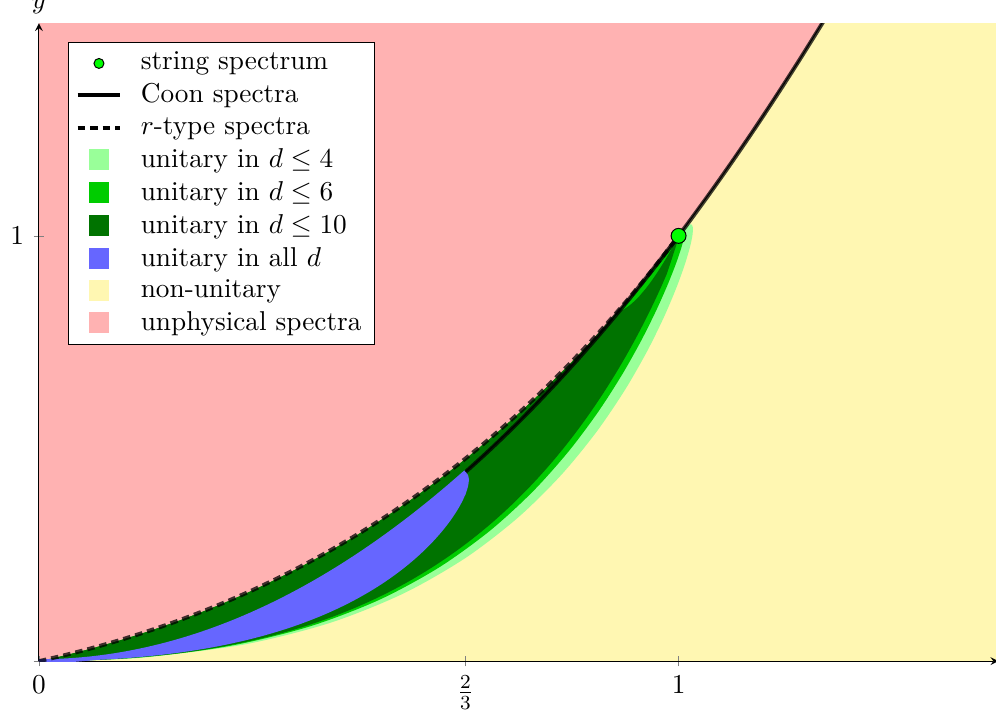
Figure 2 . The two-parameter space of solutions to the generalized Veneziano amplitude constraints with unitary regions in various dimensions. The blue region is unitary in all dimensions and includes the Coon amplitudes with 0 < q ≤ 2 . The dark green region is unitary in d ≤ 10 and includes the 3 Veneziano amplitude at x = y = 1 . The middle green region is unitary in d ≤ 6 . The light green region is unitary in d ≤ 4 . The blue region was computed analytically, and the green regions were computed by numerically analyzing the first few partial wave coefficients c n,j